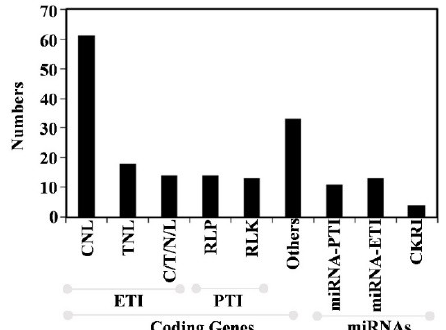
Figure 1. Categories of the genes/regulators in the three defense layers in plants. The data was downloaded from PRGdb database and the recent publications [20–62]. PTI: pathogen-associated molecular patterns (PAMP) triggered immunity; ETI: effector-triggered immunity; CRKI: cross-kingdom RNA interference.